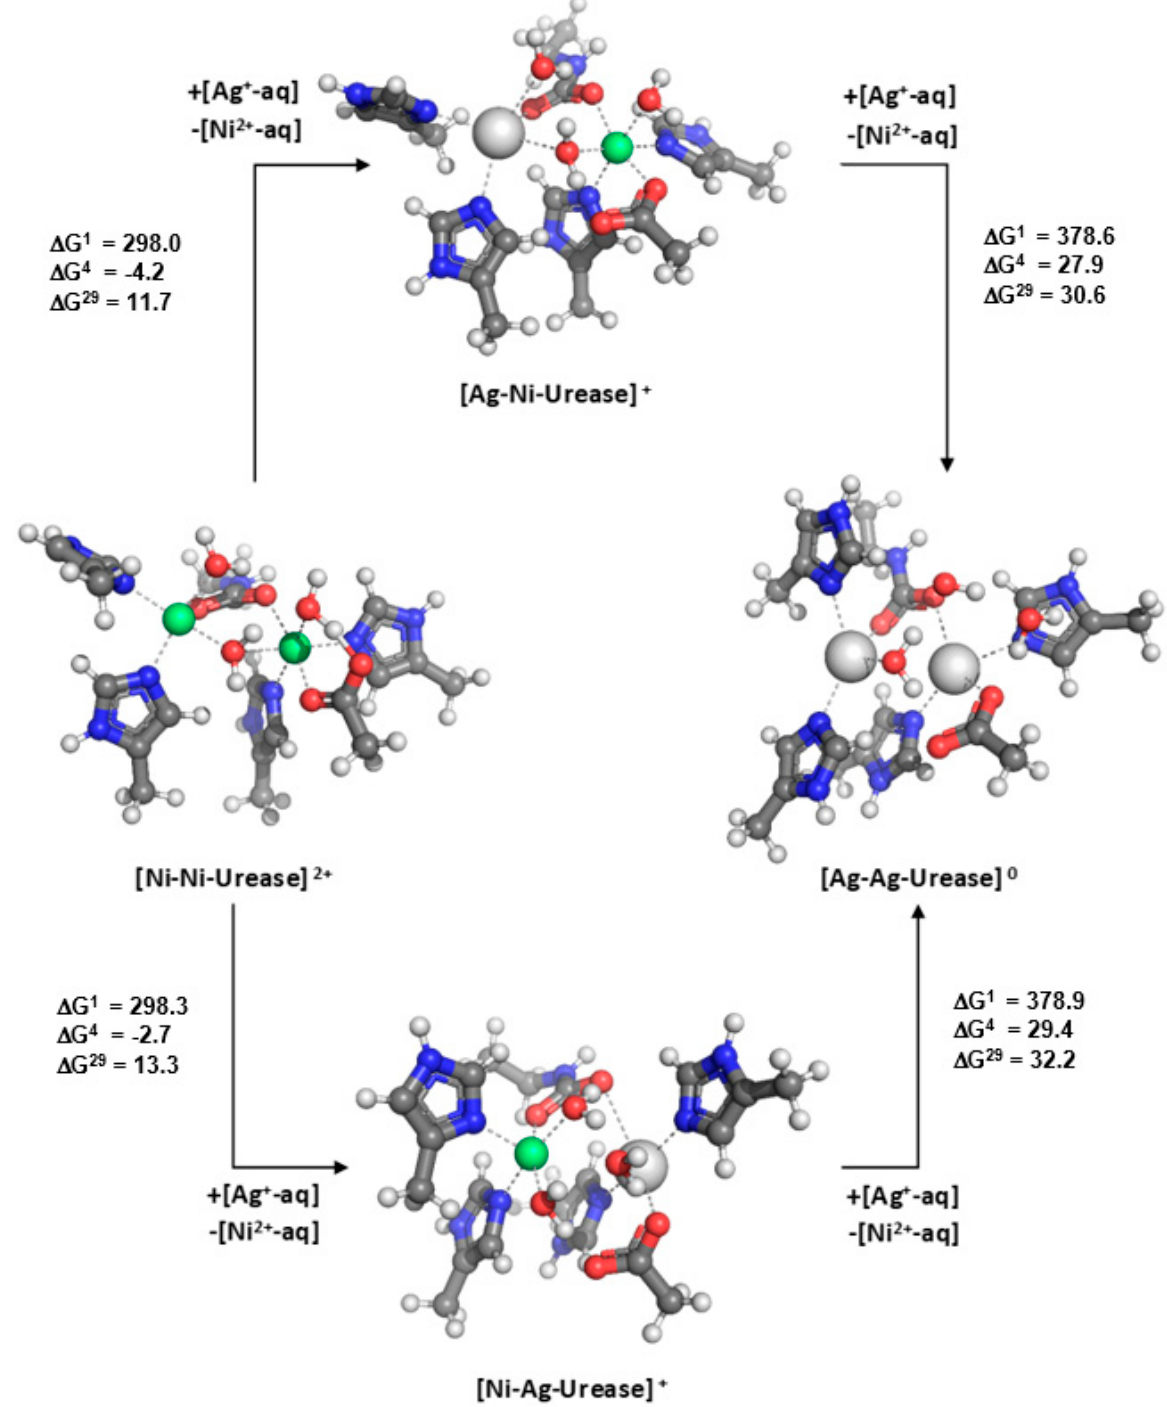
Figure 6. M06-2X/6-311++G** fully optimized structures of Ni 2+ /Ag + -loaded urease binding sites along with the Gibbs free energies, ∆ G ε (in kcal mol − 1 ), for replacing Ni 2+ with Ag + in the binding sites characterized by dielectric constant ε . ∆ G 1 refers to cation exchange free energy in the gas phase, whereas ∆ G 4 and ∆ G 29 refer to cation exchange free energies in an environment characterized by an effective dielectric constant of 4 and 29, respectively. Positive ∆ Gs suggest Ni 2+ -selective sites whereas negative free energies imply Ag + -selective constructs. Ni 2+ and Ag + are represented by green and grey spheres, respectively. Bridging carbamylated lysine is modeled by CH 3 CH 2 NHCOO − . Adapted from Ref. [70]. Copyright 2022